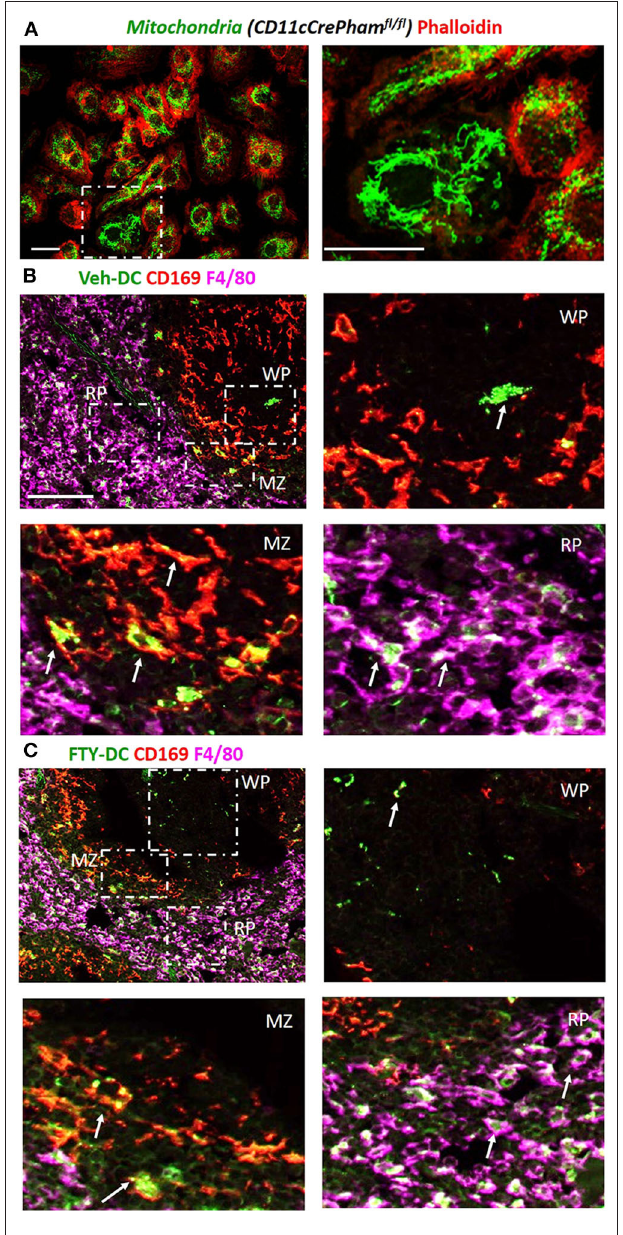
FIGURE 3 | Injected DCs are detected in recipient spleen after adoptive transfer and donate more mitochondria to splenic macrophages. (A) BMDCs were propagated from CD11cCrePham fl / fl mice. 8 day old BMDCs were grown on coverslip and labeled with phalloidin (red, actin) and endogenous mitochondria (green), Scale bar, 20 µ m; inset on right, Scale bar, 20 µ m. (B) CD11cCrePham fl / fl Veh-DC and (C) FTY-DC labeled with CD169 (red, clone MOMA-1, marginal zone macrophages) and F4/80 (magenta, red pulp macrophages). The appearance of yellow is colocalization of injected mitochondria (green) with CD169 (red) and white is colocalization of injected mitochondria (green) with F4/80 (magenta). RP, red pulp; WP, white pulp; and MZ, marginal zone. Scale bar, 100 µ m (top B,C ). Scale bar, 20 µ m (bottom B,C ). White arrows point to the taken-up mitochondria from CD11cPham fl / fl